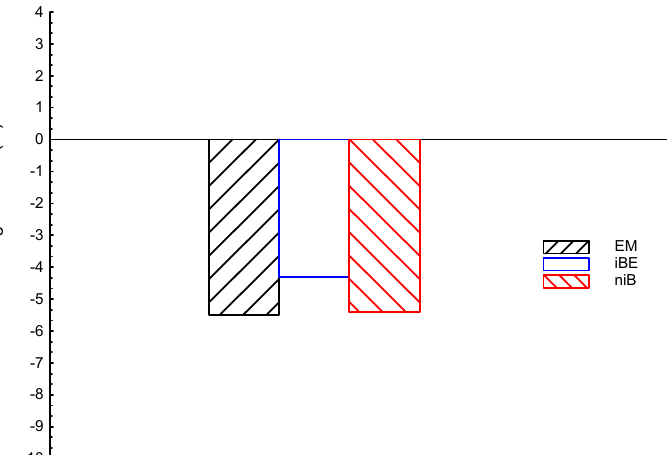
Figure 2. Exhaust gas temperature (EGT) average for ternary blended fuels of bio-ethanol–bio-methanol–gasoline (EM), iso-butanol–bio-ethanol–gasoline (iBE), and n-butanol–iso-butanol–gasoline (niB); gasoline is the reference line.